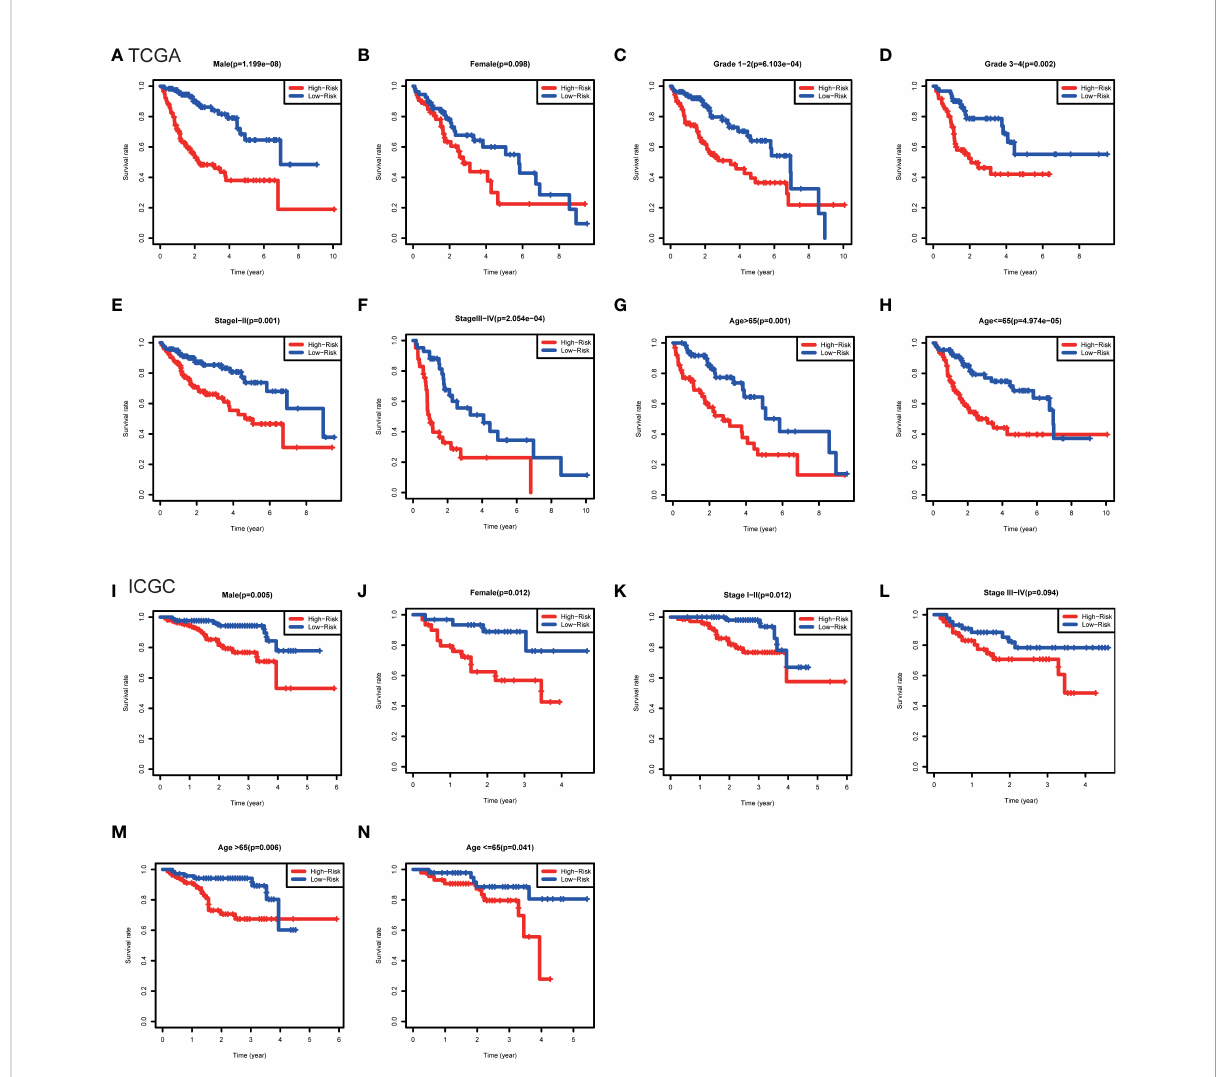
FIGURE 6 Kaplan-Meier survival analysis between subgroups strati fi ed by different clinical characteristics in the TCGA and ICGC cohorts. (A) Male, (B) female, (C) grade 1-2, (D) grade 3-4, (E) stage I-II, (F) stage III-IV, (G) age>65, (H) age<=65 in the TCGA cohort. (I) male, (J) female, (K) stage I-II, (L) stage III-IV, (M) age>65, (N) age<=65 in the ICGC